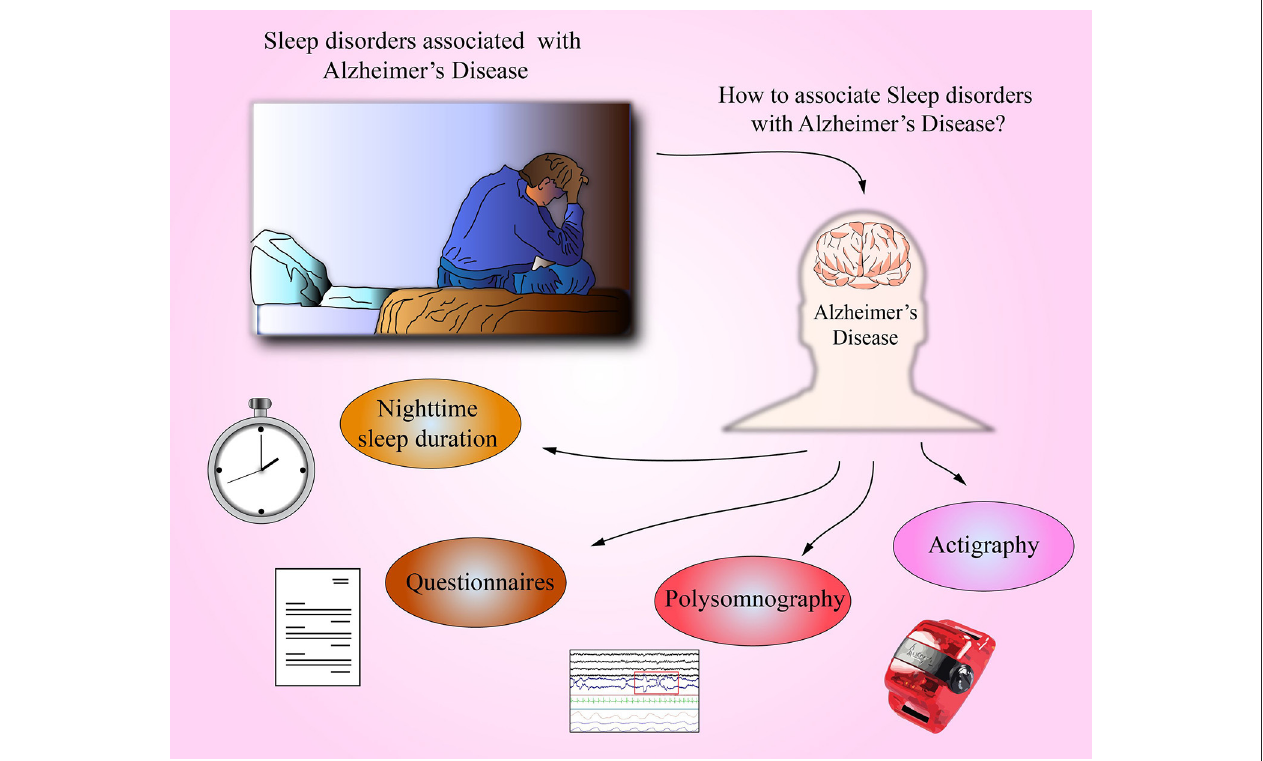
FIGURE 1 | Identification of sleep disorders and possible relationship with AD. Several sleep conditions may indicate the risk of undergo AD; for example, nighttime sleep ( < 5h) is linked in many epidemiological studies as a risk factor for AD. Additionally, it is possible to qualitatively survey for sleep quality by means of questionnaires i.e., Athens Insomnia Scale or Pittsburg Sleep Quality Index. Polysomnography is a procedure to diagnose sleep disorders, and in AD patients, it is observed prolonged sleep latency and increased number of arousals. Finally, some portable equipment like Actigraph can provide key data of sleep quality by measuring the wakefulness and sleep activity in several days (10 days